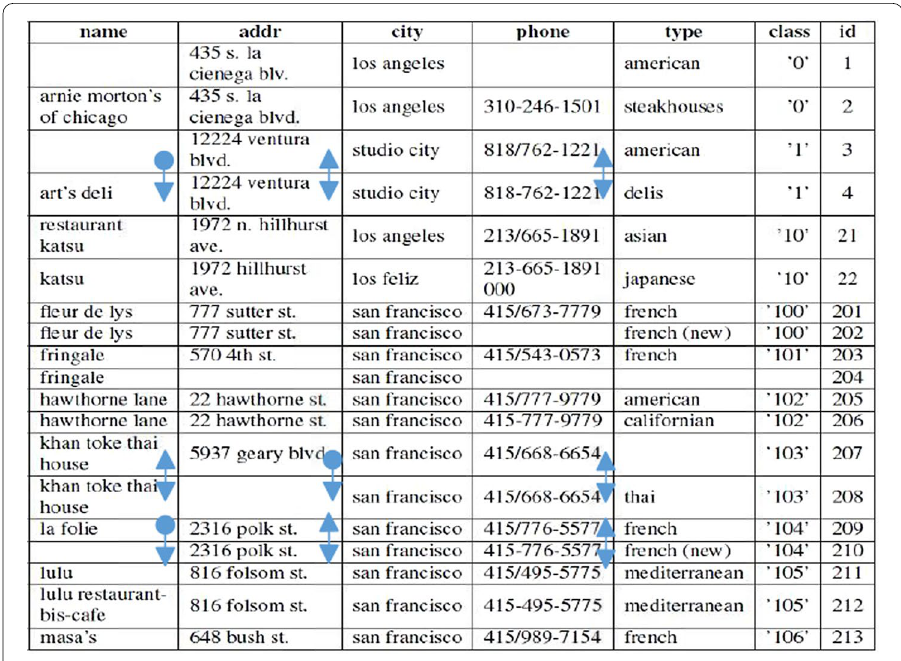
Fig. 2 An example of missing values